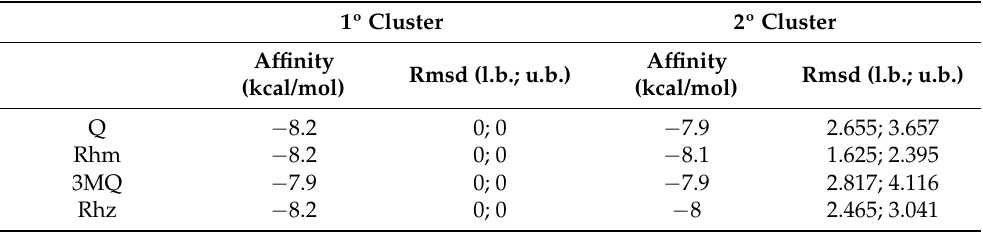
Table 4. Binding free energy (affinity) and rmsd values of BthTX-I with each quercetin derivative. 1º Cluster 2º Cluster Affinity Affinity Rmsd (l.b.; u.b.) Rmsd (l.b.; (kcal/mol) (kcal/mol)